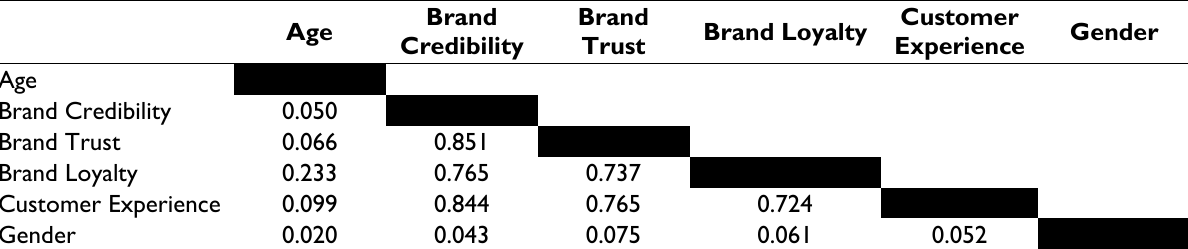
Table 4. Discriminant Validity: Heterotrait-Monotrait Ratio